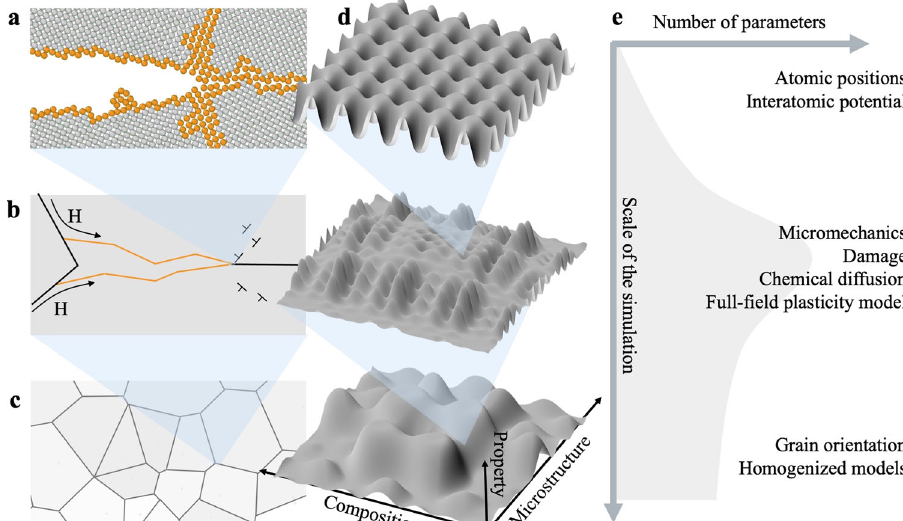
Fig. 1 Multi-scale, multi-physics aspects of material modeling and simulation. a – c Fracture and dislocation activity at the crack tip and triple junction during loading are depicted at the atomic scale ( a ), the single grain scale ( b ), and polygrain scale ( c ). ( d ) Abstract visualization of microstructure-composition-property space at these scales. ( e ) Schematic of simulation scale versus the number of parameters involved based on ideas in ref. 238 . The complexity of microstructure-composition-property relationships at different scales poses a tremendous challenge to determining optimal material design and discovering new